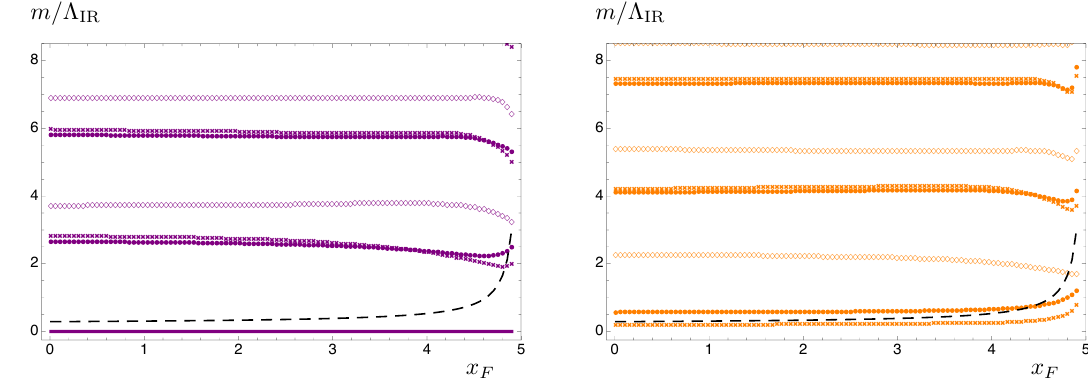
Figure 21 . Model I. Fermionic spectrum as a function of x F for ∆ = 2 . 5 , g 5 = 8 , ˜ λ 0 , IR = ˜ λ (max) , 0 , IR and ∆ R = 1 . 6 , 2 . 5 , 2 . 75 (diamonds, dots, crosses). The left and right panels correspond to imposing (+) and ( − ) IR boundary conditions, respectively. The solid line in the left panel indicates the presence of a massless state. The decay constant ˜ f is represented by the dashed black line. The ratio between the UV and IR energy scales is equal to Λ UV = 10 3 . In the numerics, we used the IR Λ IR regulator r 1 = 10 − 12 for x F ≤ 4 . 5 , while for x F > 4 . 5 we used r 1 = 10 − 30 in order to minimize